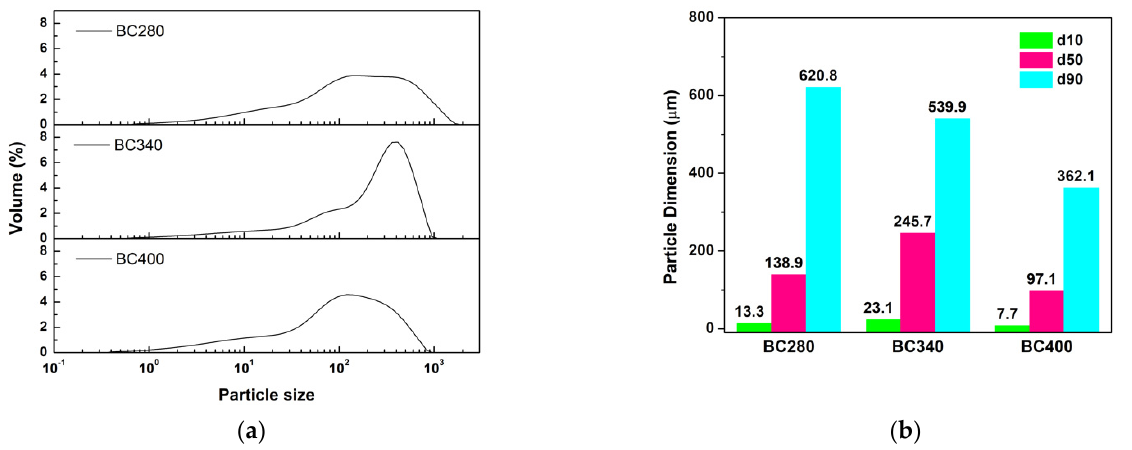
Figure 1. ( a ) Distribution of size dimensions and ( b ) fraction of particles for BC produced at different temperatures, i.e., 280, 340 and 400 °C.